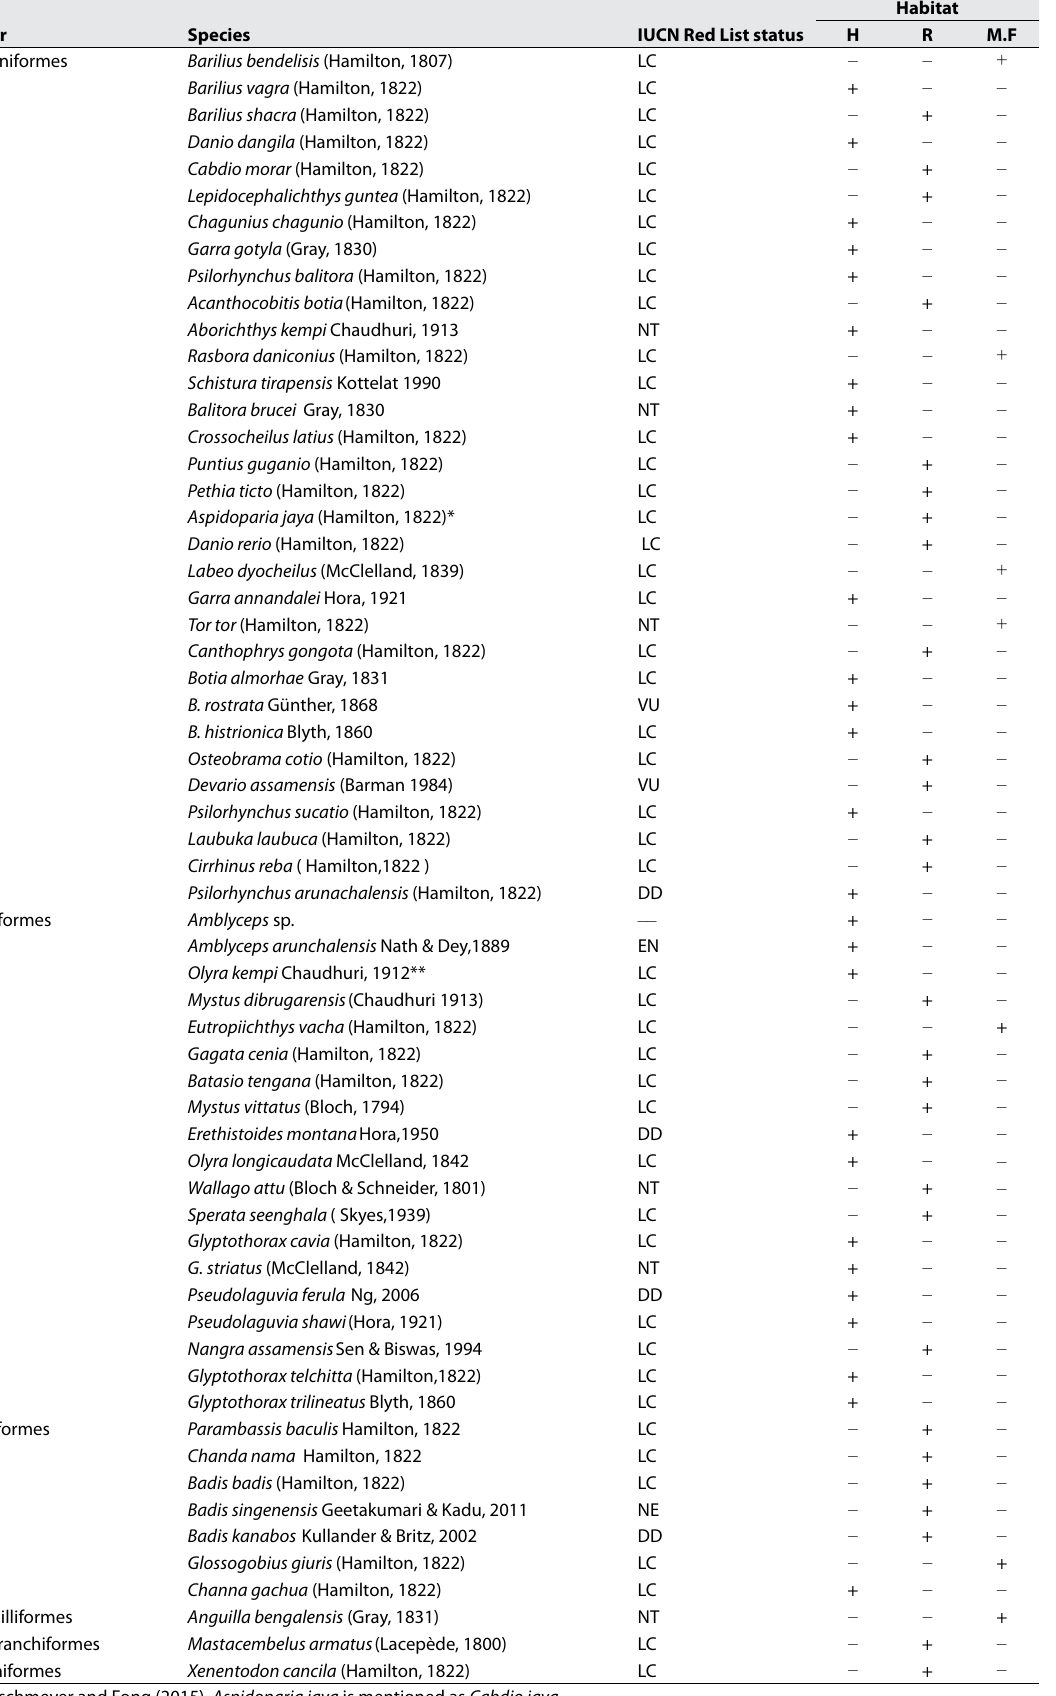
Table 1. List of fishes from the Ranganadi River. EN = Endangered, VU = Vulnerable, NE = Not Evaluated, DD = Data Deficient, LC = Least Concern, NT = Near Threatened, H = Hill Stream, R = Riverine and MF = Migratory Fish.